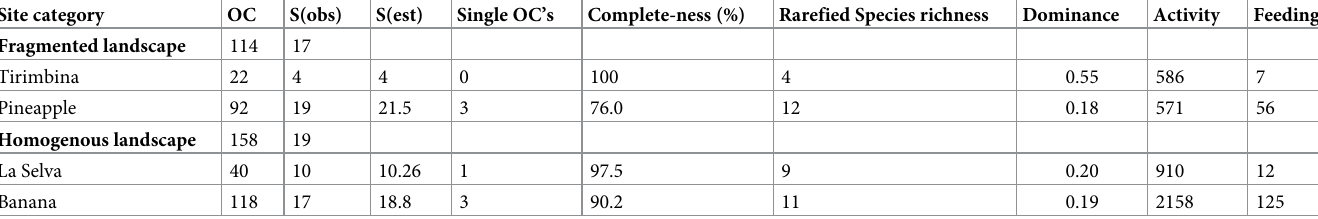
Table 2. Activity and percentage of inventory completeness of aerial insectivorous bats for each habitat category.